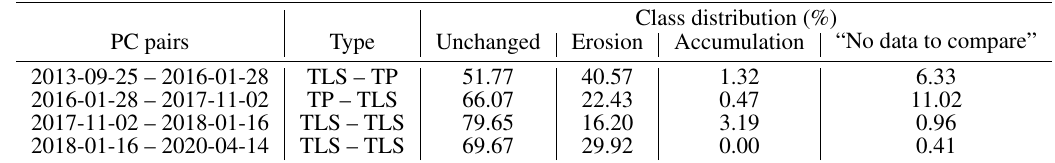
Table 2. Varengeville-sur-Mer PC